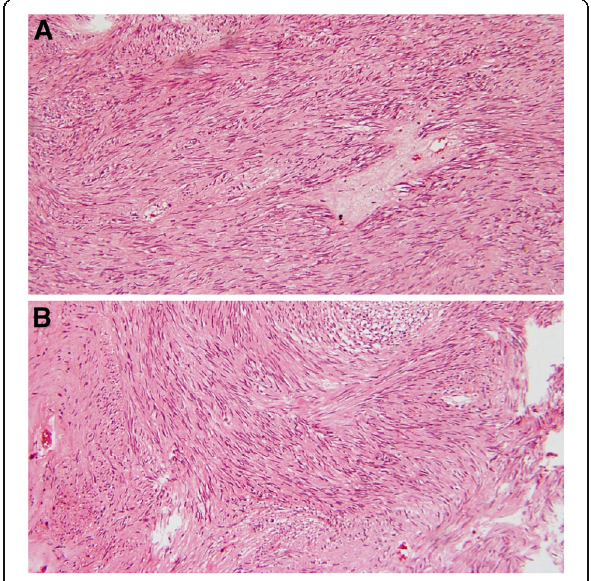
Fig. 2 a , b Both show interlacing bundles of spindle cells without atypia. The tumour cells have uniform nuclei which are slender with tapered ends. No mitosis is seen in the tumour sections (H and E stain, ×